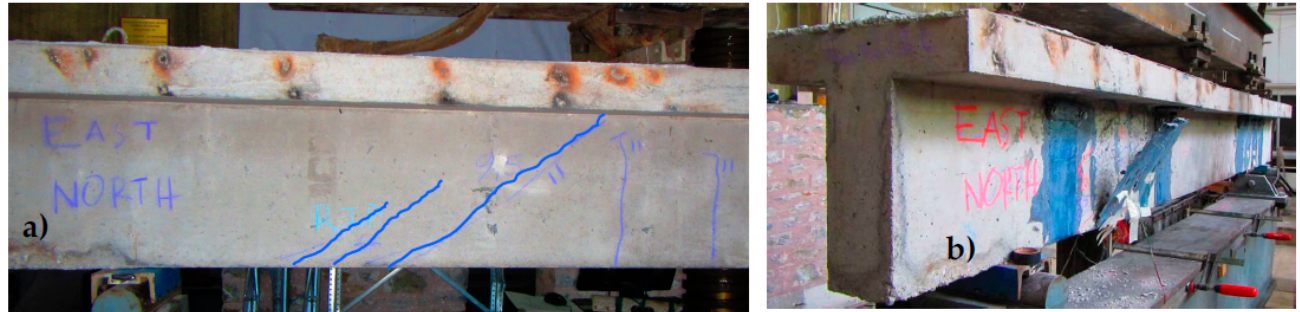
Figure 18. Comparison of the measured response between the Virgin RC prototype T-beam and this T-beam having been retrofitted with the 1 st st rengthening scheme . ( a ) Shear force versus the deflection at mid-span. ( b ) Bending moment versus the deflection at mid-span. 4.3. Prototype RC T-Beam witht External CFRP Shear Reiforcement Having all the CFRP Stirups either Anchored at the West Part or Closed CFRP Rope Both at the East Part (2nd Shear Strengthening Scheme) At this stage (2nd shear strengthening scheme ), the two debonded at the previous stage unanchored CFRP strips, located at the East part, were replaced by three closed hoop CFRP anchor rope stirrups similar to the one tested in Section 3.3 (see Section 2.2 and Figure 10b). These closed hoop CFRP ropes can be seen in Figure 19a, whereas, Fig- ure 19b depicts the traces of the diagonal cracks. Further development of these diagonal cracks was successfully prohibited by these closed hoop anchor ropes. Figure 20a,b depicts the comparison of the measured response between the Virgin T-beam and the T-beam having been retrofitted with either the 1 st or 2nd st rengthening scheme ( a-Shear-force versus the deflection at mid-span, b-Bending-moment versus the deflection at mid-span). This 2nd st rengthening scheme was capable of upgrading the shear resistance of the specimen in such a way that the flexural mode of failure developed this time. This is evident from the ductile nature of the variation of either the shear force (Q, Figure 20a) or the bending moment (M, Figure 20b) response versus the deflection at mid-span. The maximum shear force recorded for the 2nd shear strengthening scheme was equal to 197.43 kN and the corresponding maximum bending moment value was equal to 177.68 k Nm.